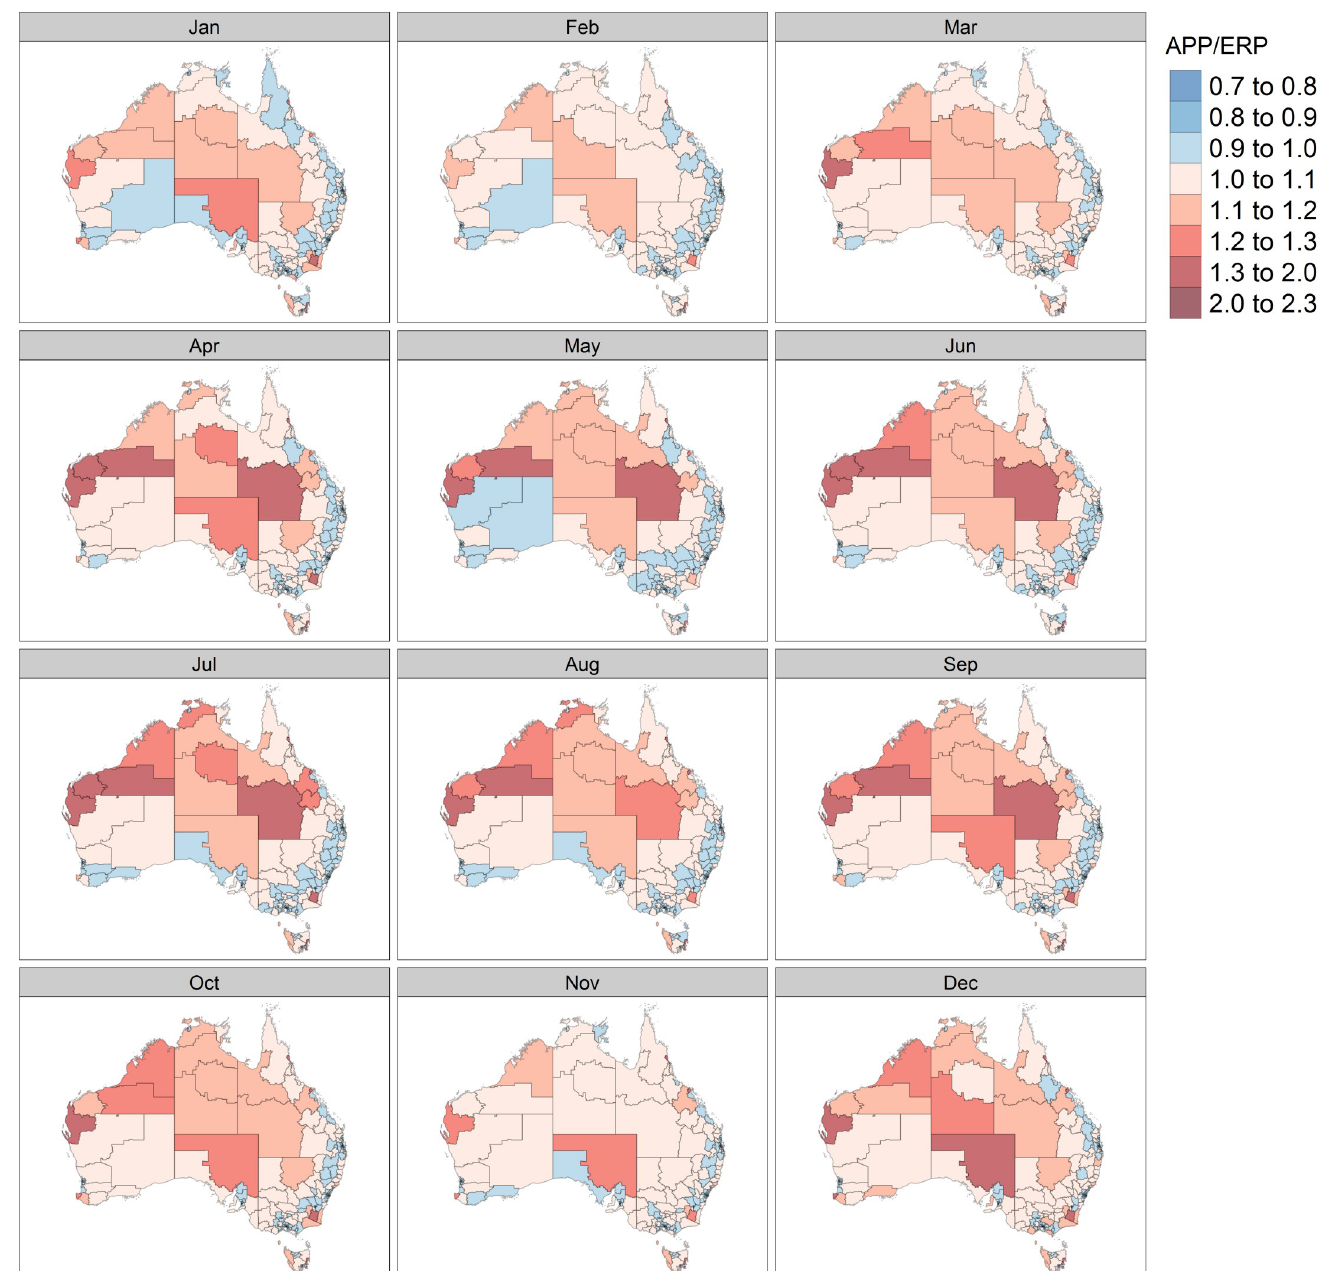
Fig 3. Monthly variations in ratio of the APP to ERP across SA3 regions in Australia. Source: authors’ own calculations. The maps were created using tmap package in R [51]. Freely available digital boundaries for SA3s were obtained from the ABS: https://www.abs.gov.au/websitedbs/d3310114.nsf/home/digital